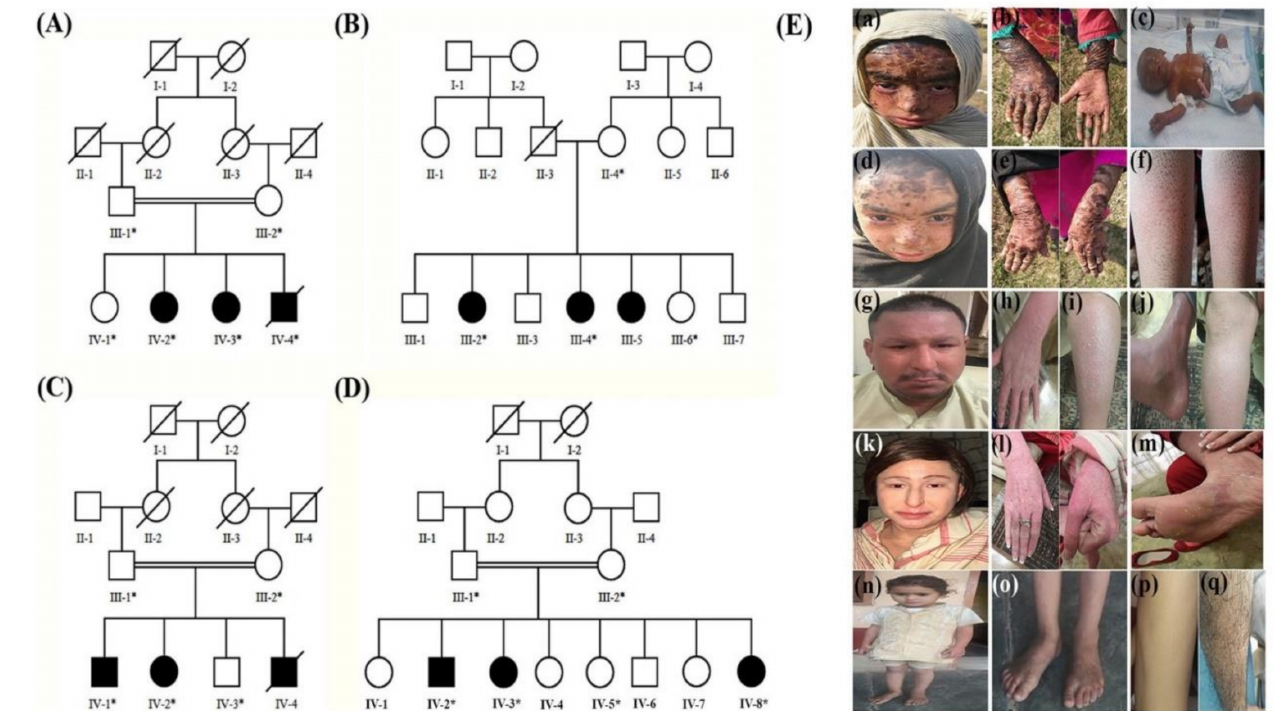
Figure 1. ( A – D ) Pedigrees of the families A, B, C, and D segregating different forms of ichthyoses in autosomal recessive manner. Double lines are indicative of consanguineous union. Circles and squares represent females and males, respectively. Clear symbols represent unaffected individuals while filled symbols represent affected individuals. The individual numbers labeled with asterisks indicates the samples which are available for the studies. ( E ) Clinical phenotype of different forms of ichthyosis in the four families. ( a , b , d , e ) Female patients IV-2 and IV-3 from Family A showing classical features of LI and ( c ) newborn IV-4 from the same family with collodion membrane. ( f ) Patient III-2 from Family B with clinical representation of ARCI. ( g – m ) A male (IV-1) and a female (IV-2) patient of Family C show the typical clinical phenotypes of NS. ( n – q ) Two affected patients IV-2 and IV-8 of Family D with phenotypic features of ichthyosis